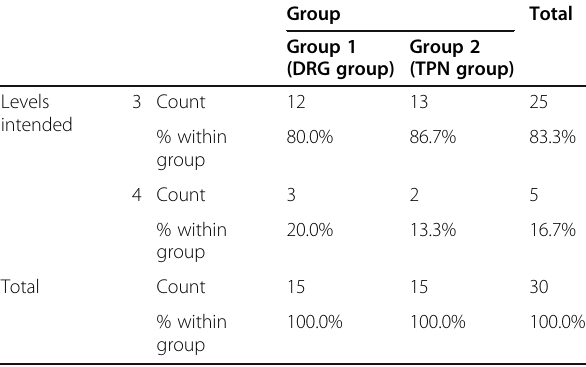
(Fig. 1a – e) versus RF of the thoracic paravertebral nerves (TPN) (Fig. 2a,